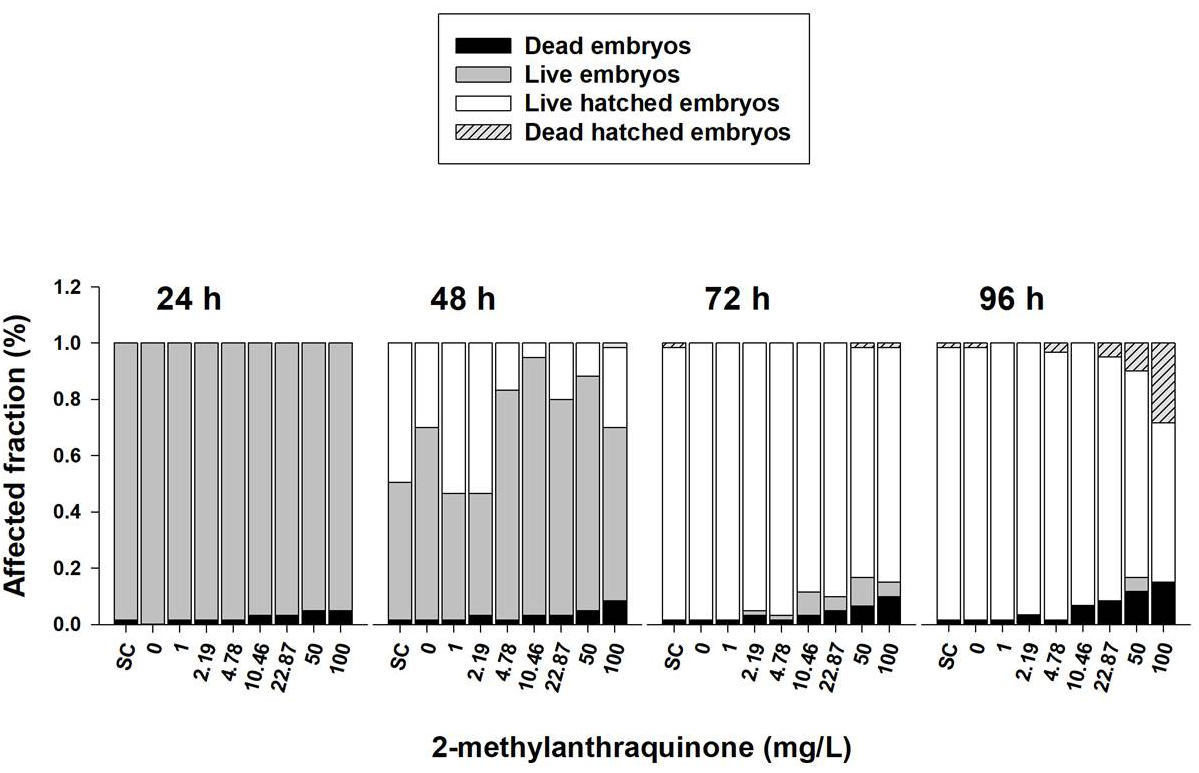
Figure 2 – An overview FET-test showing low mortality and embryo malformation rates of 2-methylanthraquinone to zebrafish.